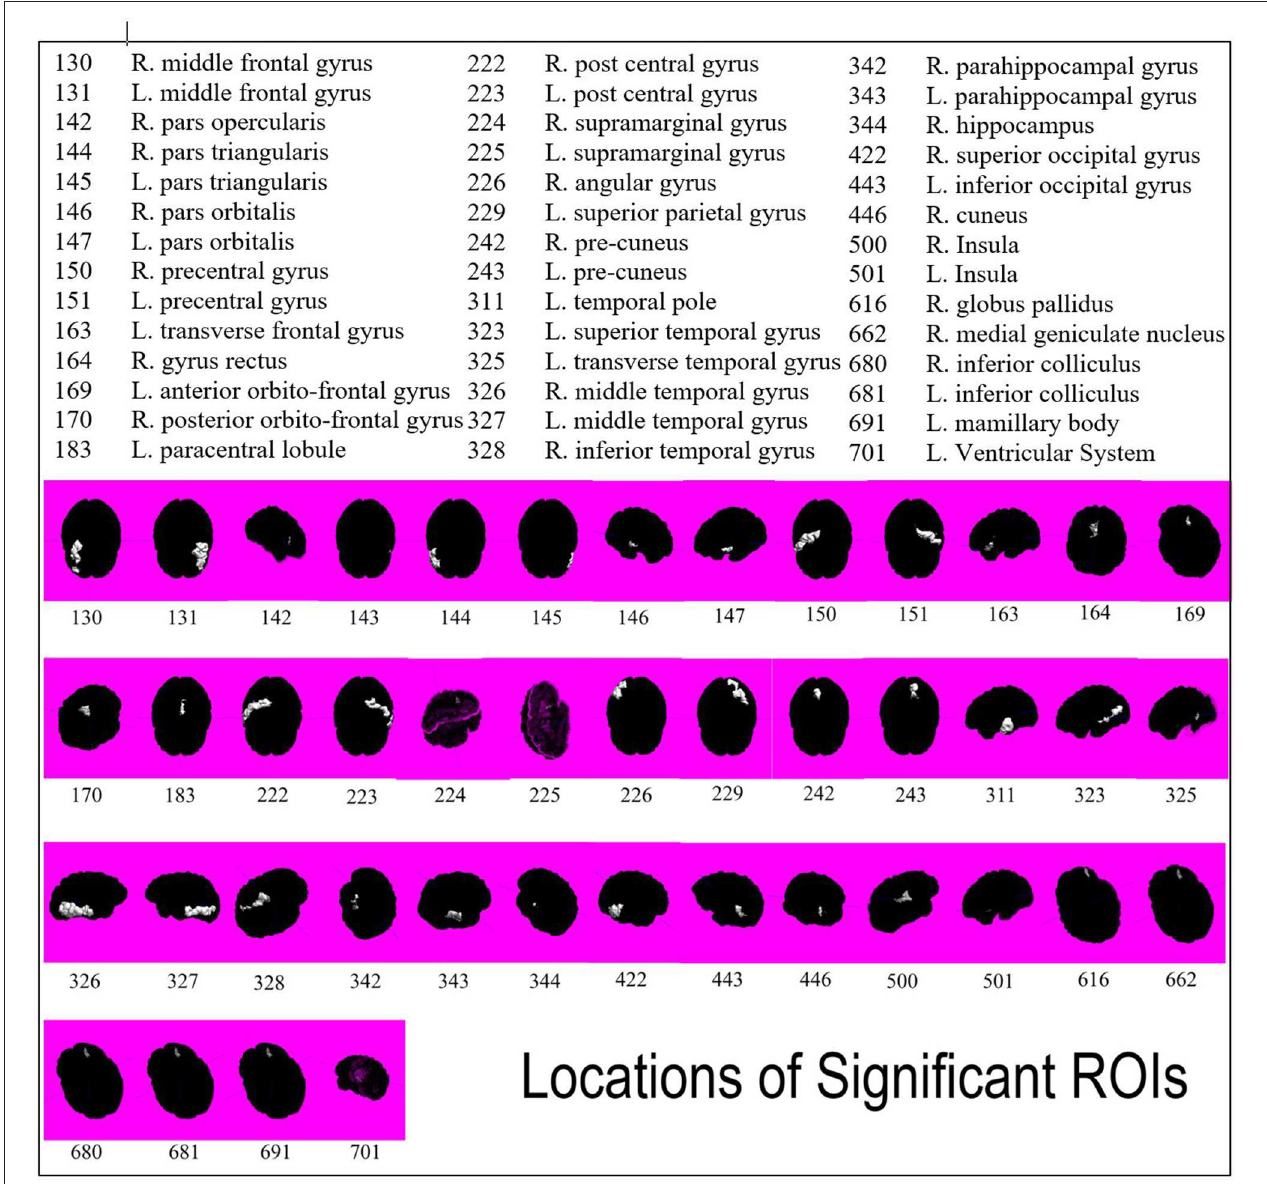
FIGURE 2 | Spatial representation of all forty-two ROIs found to be significant in differentiating seizure and non-seizure brain tumor patients. ROIs are indicated by white highlight and numbers are associated by